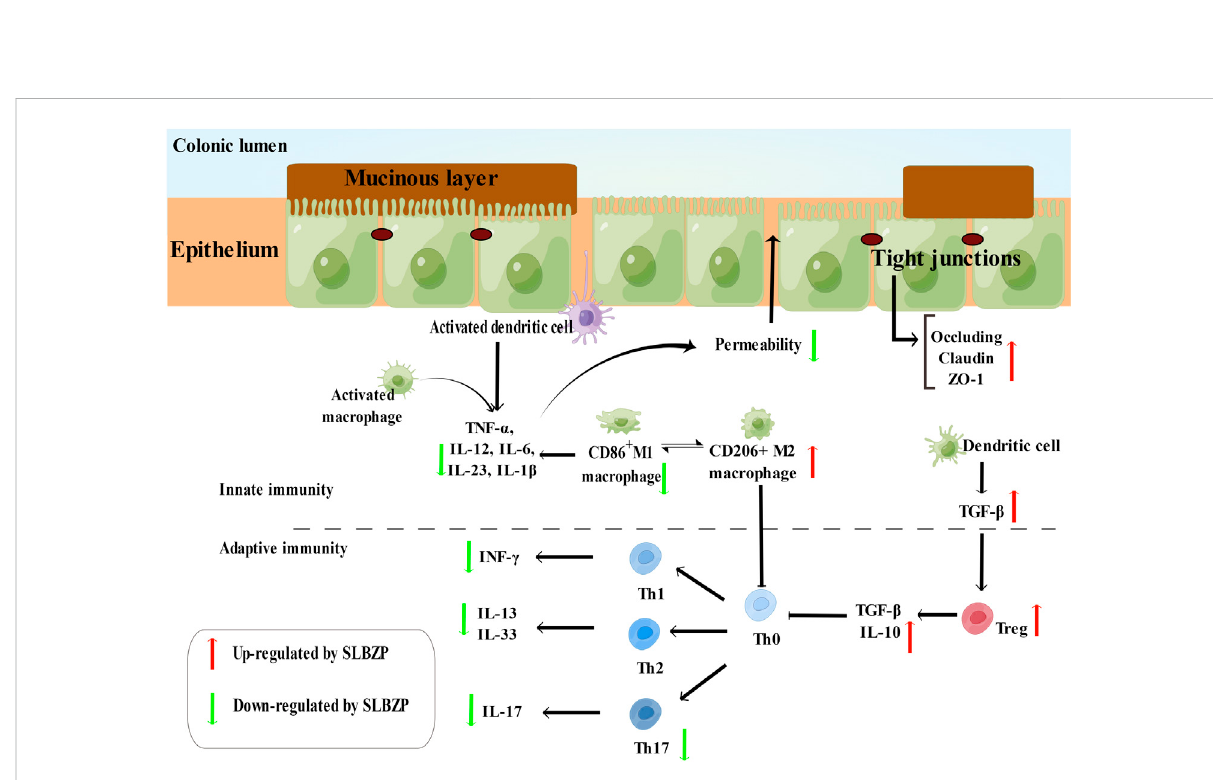
FIGURE 3 Regulation of Immune functions and intestinal permeability of SLBZP in